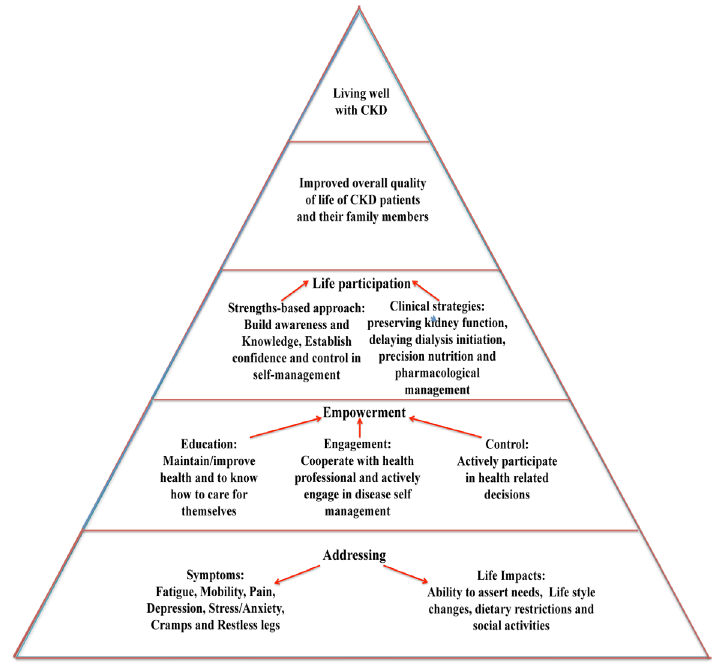
Figure 1. Representation of components of the quality of life of the CKD patients and care